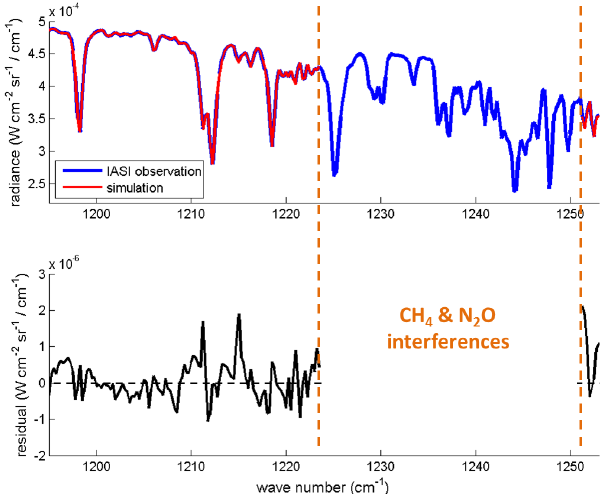
Figure 2. Upper panel: IASI observed spectra (blue curve), the cal- culated spectra (red curve) in radiance units for August 2011. Bot- tom panel: the corresponding residual is plotted in black, with an rms of 1.05 × 10 − 6 Wcm − 2 sr − 1 /cm − 1 . Note the factor 100 be- tween the residual and the radiance. The gap on the residual high- lights the part where the retrieval is not performed, avoiding major CH 4 and N 2 O